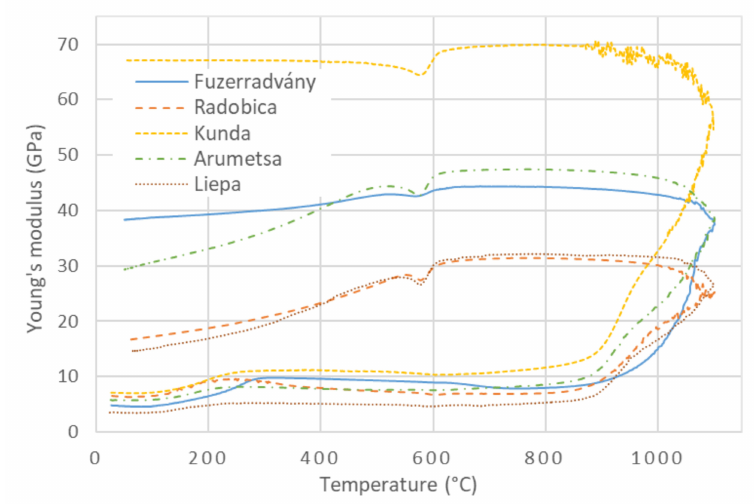
Figure 3. Normalized bulk density of investigated